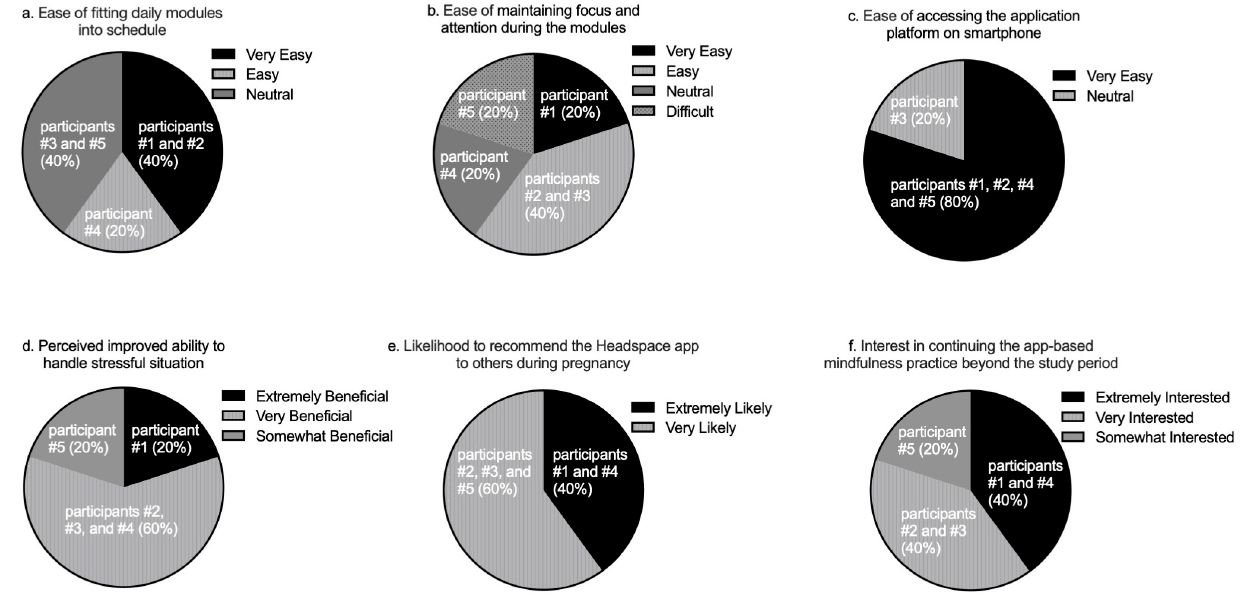
Figure 1. Participants’ responses regarding their experiences in participating in the study and using the Headspace app ( N = 5). All questions were asked on a 5-point Likert scale as follows: ( a – c ) response options ranged from very difficult to very easy; ( d ) response options ranged from not at all beneficial to extremely beneficial; ( e ) response options ranged from extremely unlikely to extremely likely; ( f ) response options ranged from extremely uninterested to extremely interested.